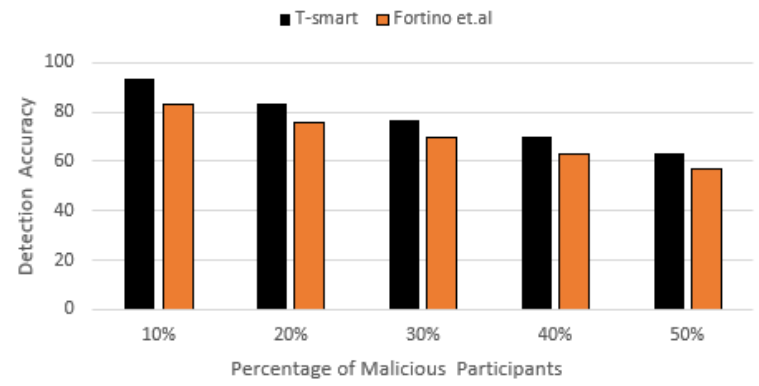
Figure 3. Detection Accuracy with 10–50% dishonest